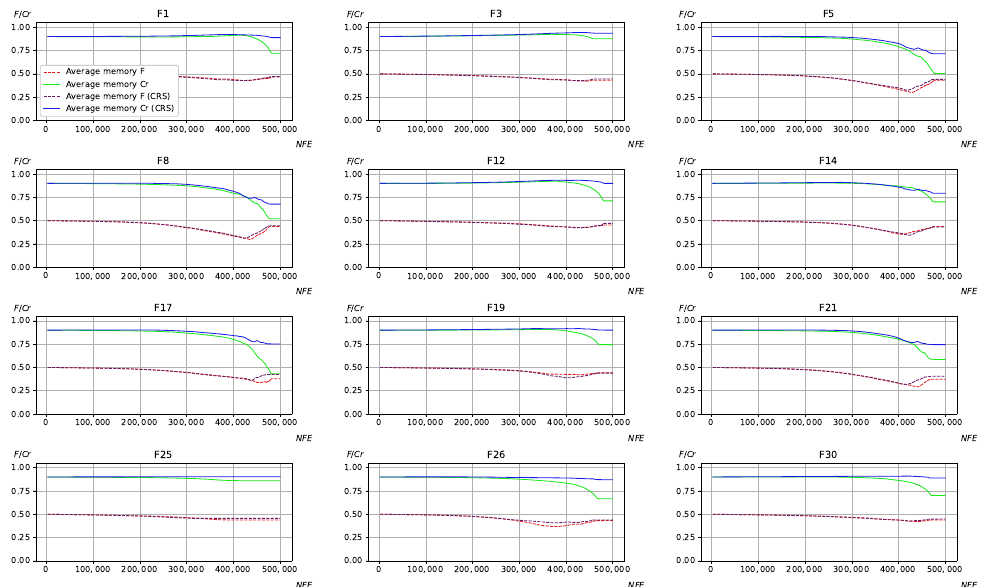
Figure 5. Parameter adaptation with and without crossover rate sorting, NL-SHADE-LBC, CEC 2017, 50 ∗ D .